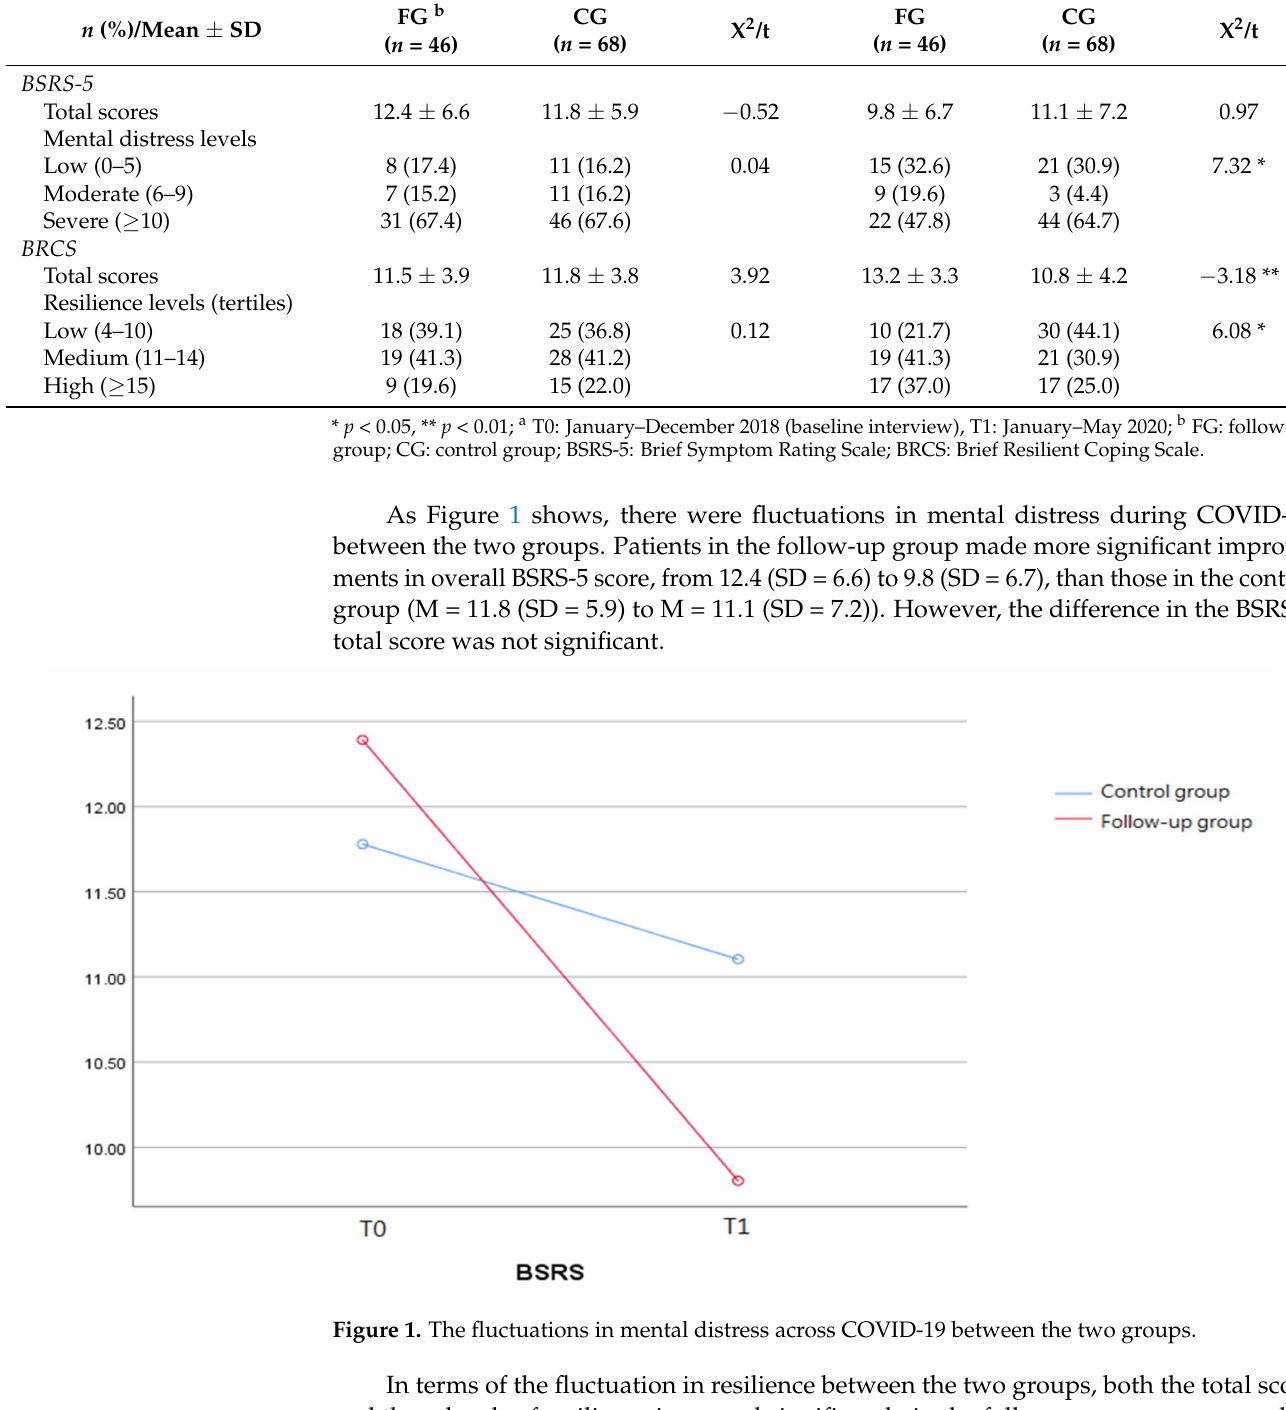
Table 3. The trend of mental distress and resilience before and during the COVID-19 outbreak (N = 114). T0 a T1